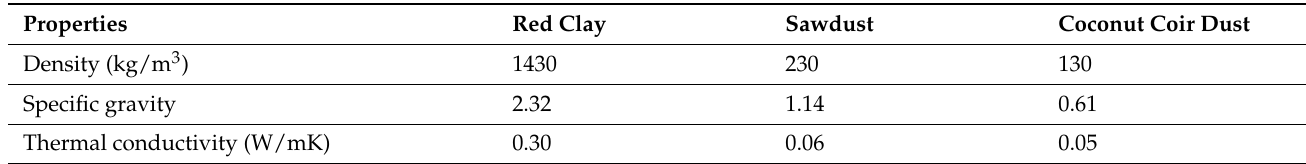
Table 1. Thermophysical properties of raw